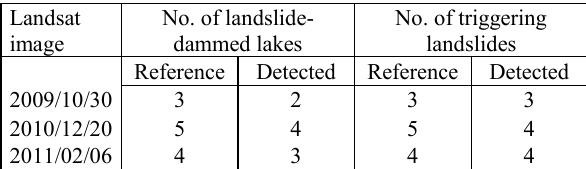
Table 2. Reference and detected landslide-dammed lakes and the landslides that most probably formed the dams.